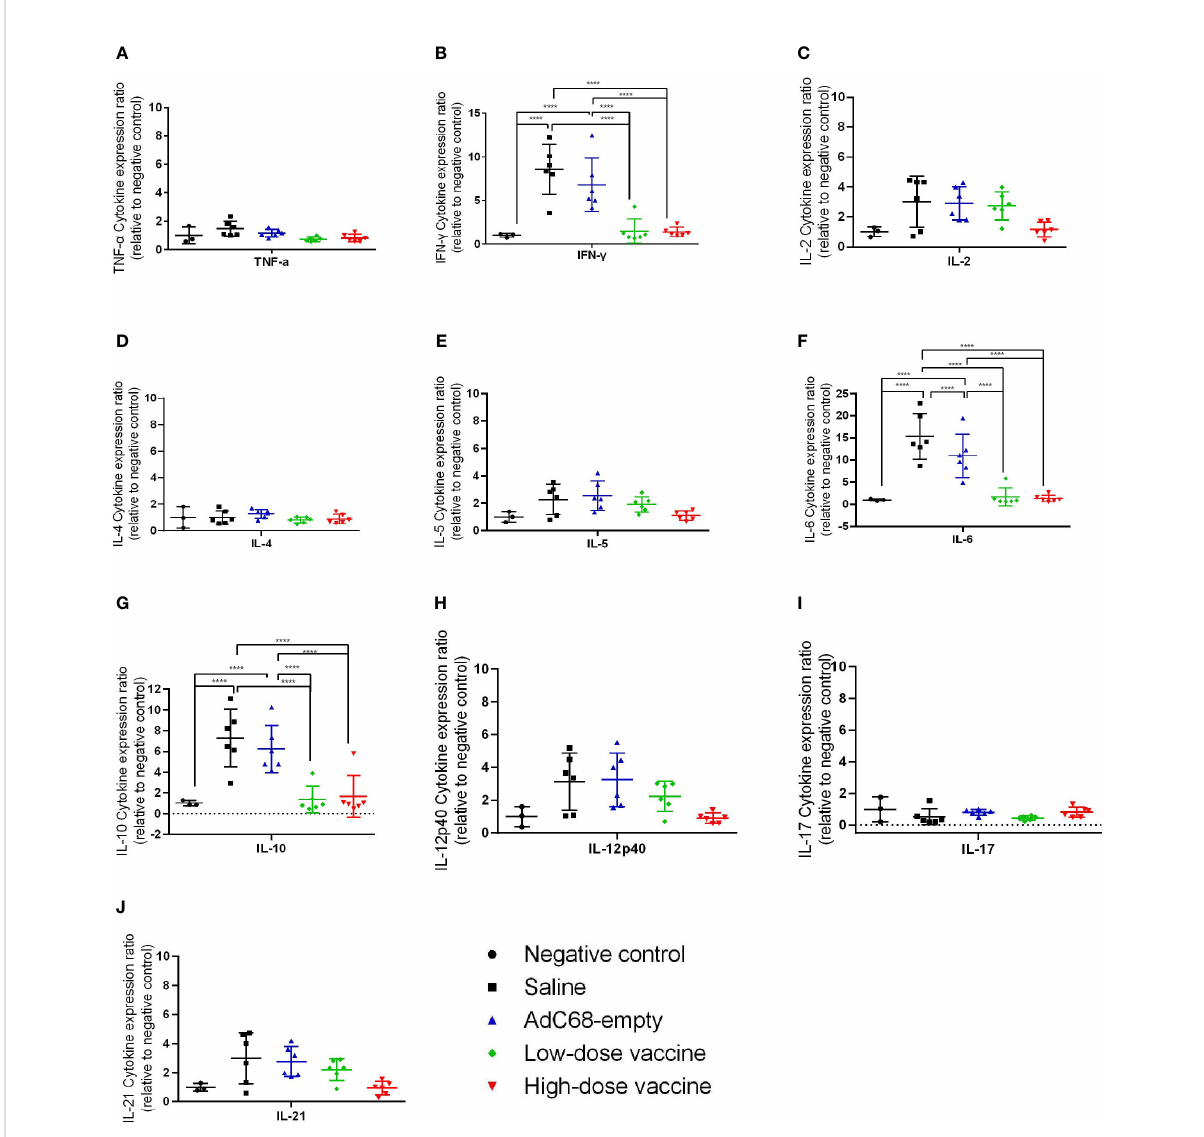
FIGURE 7 Ratios of cytokine expression levels in the lungs of golden Syrian hamsters at dpi 3. The cytokine expression levels in the lungs of golden Syrian hamsters were determined by RT-qPCR at dpi 3. (A) Ratios of TNF- a cytokine expression levels in the lungs of golden Syrian hamsters at dpi 3, (B) Ratios of IFN- g cytokine expression levels in the lungs of golden Syrian hamsters at dpi 3, (C) Ratios of IL-2 cytokine expression levels in the lungs of golden Syrian hamsters at dpi 3, (D) Ratios of IL-4 cytokine expression levels in the lungs of golden Syrian hamsters at dpi 3, (E) Ratios of IL-5 cytokine expression levels in the lungs of golden Syrian hamsters at dpi 3, (F) Ratios of IL-6 cytokine expression levels in the lungs of golden Syrian hamsters at dpi 3, (G) Ratios of IL-10 cytokine expression levels in the lungs of golden Syrian hamsters at dpi 3, (H) Ratios of IL- 12p40 cytokine expression levels in the lungs of golden Syrian hamsters at dpi 3, (I) Ratios of IL-17 cytokine expression levels in the lungs of golden Syrian hamsters at dpi 3, (J) Ratios of IL-21 cytokine expression levels in the lungs of golden Syrian hamsters at dpi 3. **** p <